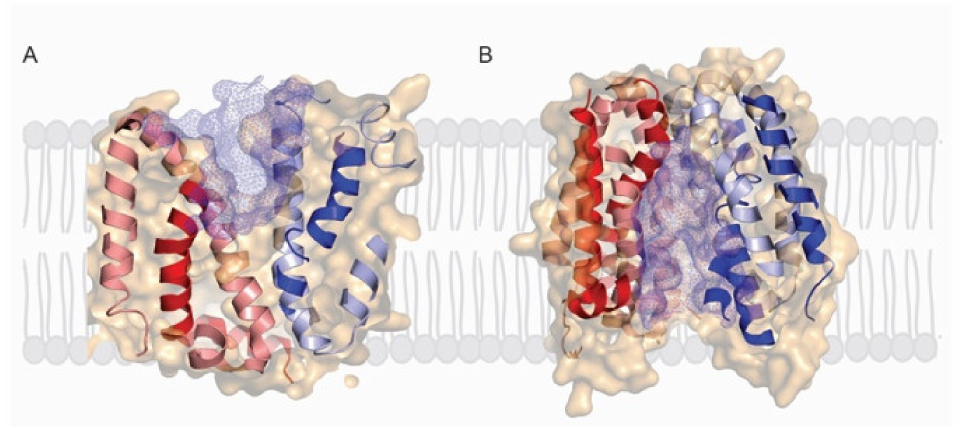
Figure 5. Alternating access of LacY . ( A ) Slice through surface of the partial outward structure of LacY (PDB: 5GXB) viewed from the membrane plane showing the extracellular cavity (blue mesh). ( B ) Slice through surface of the inward-facing structure of LacY (PDB: 1PV6) in the membrane plane showing the intracellular cavity (blue mesh). The characteristic 6TM repeat is shown in blue (TM1–TM6) and red (TM7–TM12) and the surface is shown in